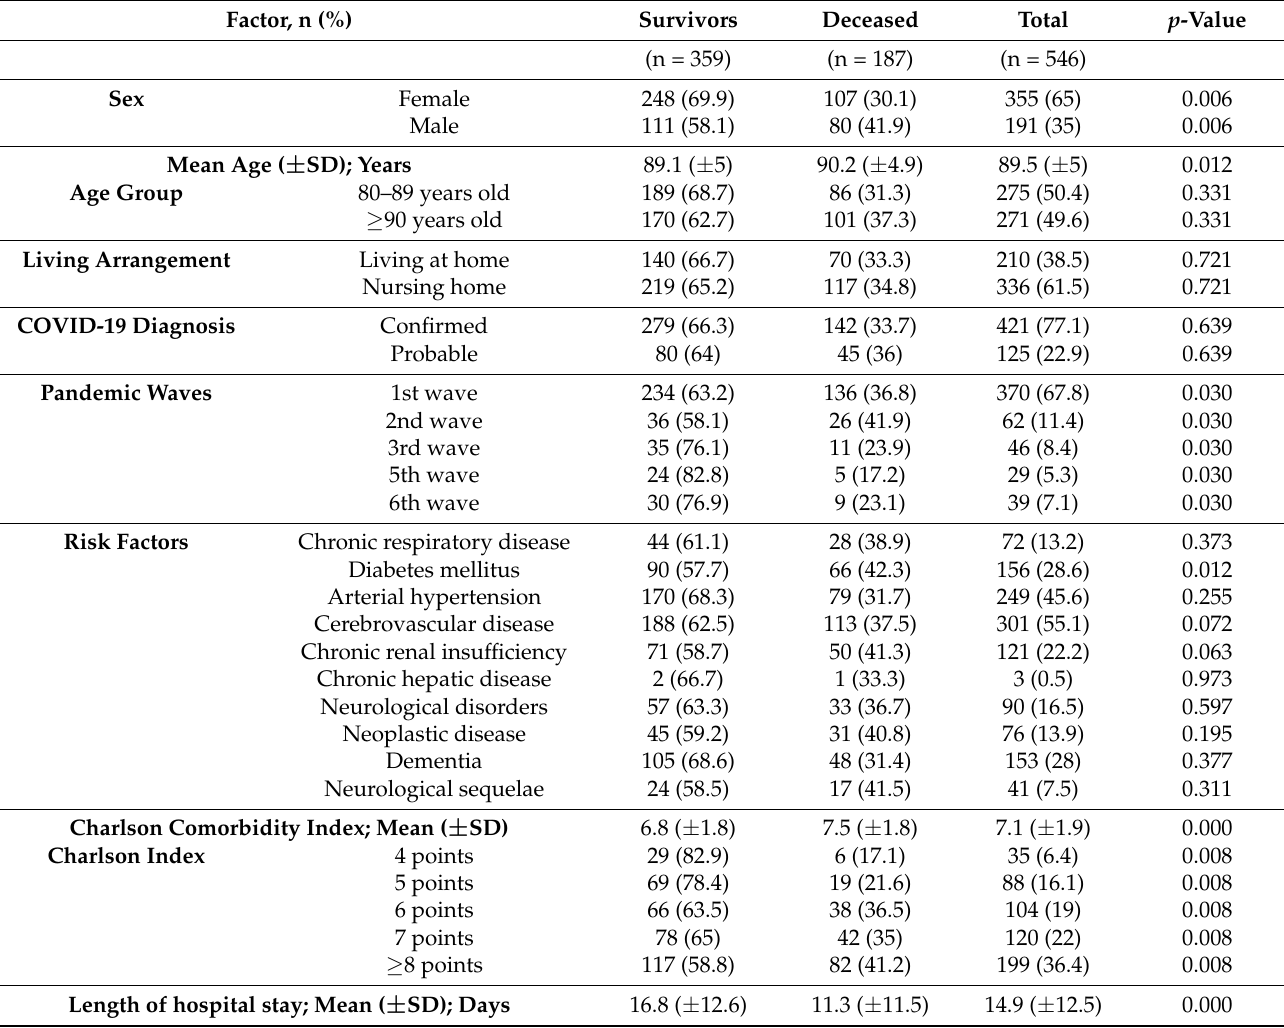
Table 3. Clinical and sociodemographic factors among patients who survived and died, infected by SARS-CoV-2 in HCCR.